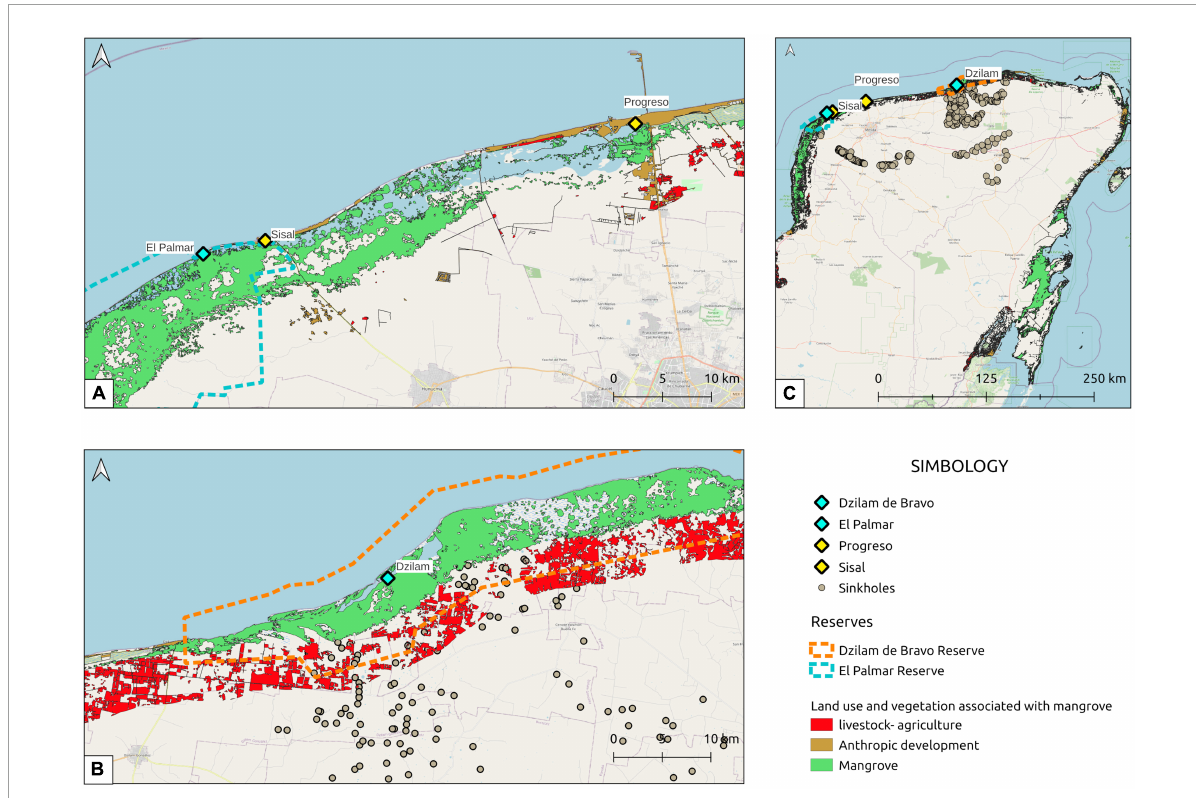
FIGURE1 Locations of sampling sites on the Yucatan coast. (A) The sampling sites of El Palmar, Sisal, and Progreso on the Yucatan coast are shown. (B) Bocas de Dzilam sampling site and its proximity to an area of great livestock and agricultural activity are shown. (C) The zone of the Yucatan Peninsula and the ring of cenotes is shown, as well as the location of the four sampled sites. Yellow diamonds show contaminated sampling sites (Sisal and Progreso); while the diamonds in blue show the ecological reserves where sampling was carried out (El Palmar and Dzilam). The ring of cenotes over the Yucatan Peninsula is also shown with the gray